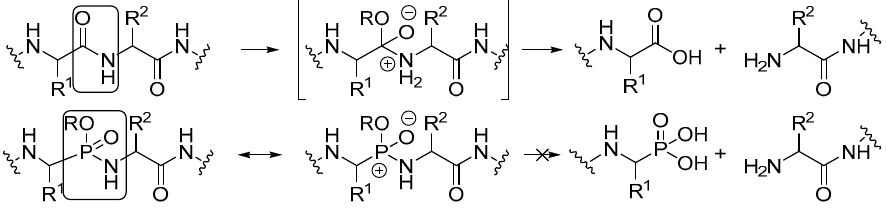
Figure 1. Phosphonopeptides mimic the transition state for peptide cleavage.